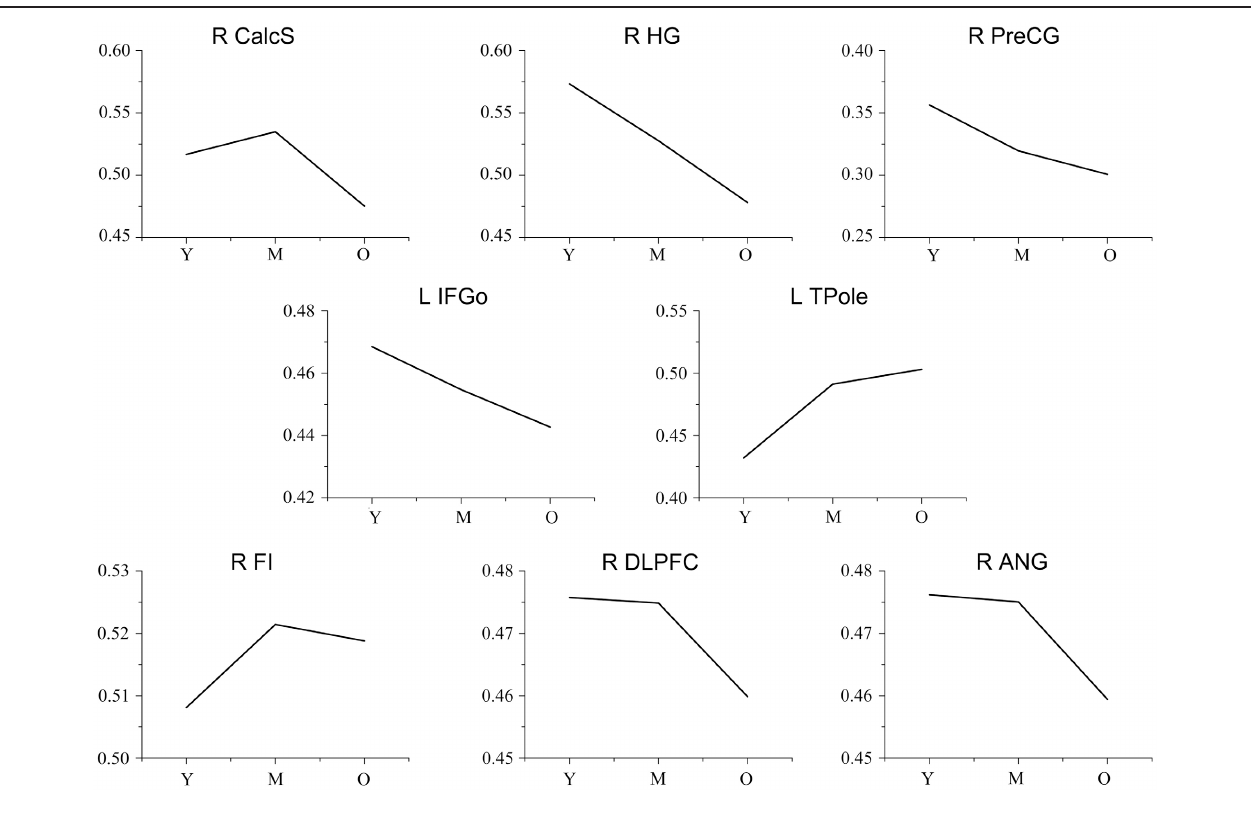
FIGURE A2 | Trajectories of the gray matter volume for each seed. The y-axis represents the mean gray matter volume for each age group. Abbreviations: Calcs, calcarine sulcus; HG, Heschl’s gyrus; PreCG, precentral